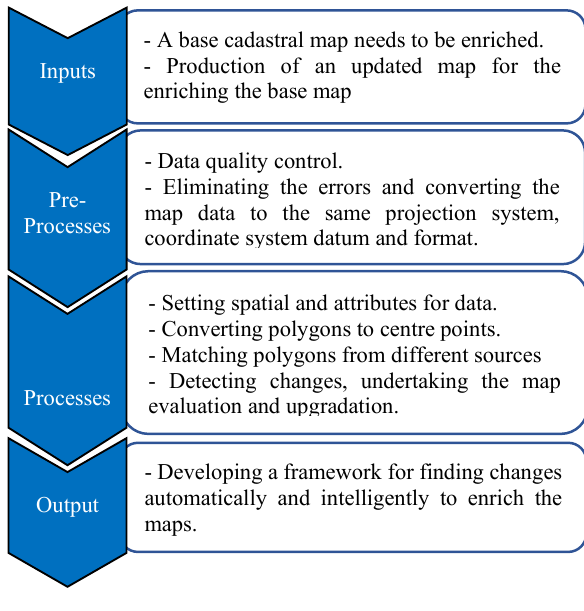
Figure 1. Research